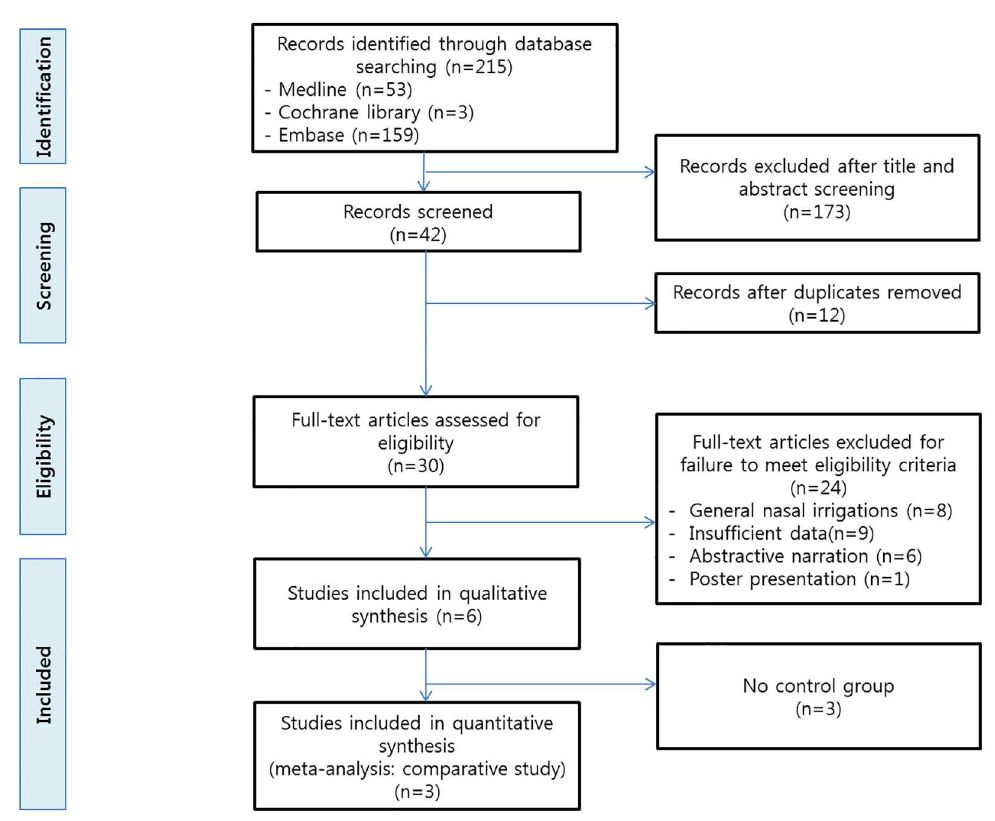
Fig 1. PRISMA guidelines for the study literature search (n = number of